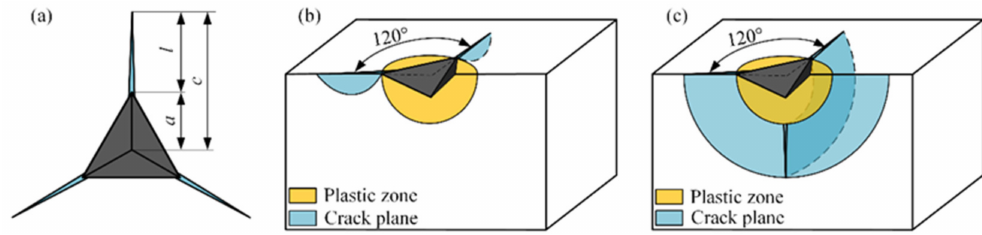
Figure 3. Illustration of typical radial crack propagation for a Berkovich indenter: ( a ) the top view of indentation-induced crack geometries, ( b ) the Palmqvist crack system, and ( c ) the half-penny crack